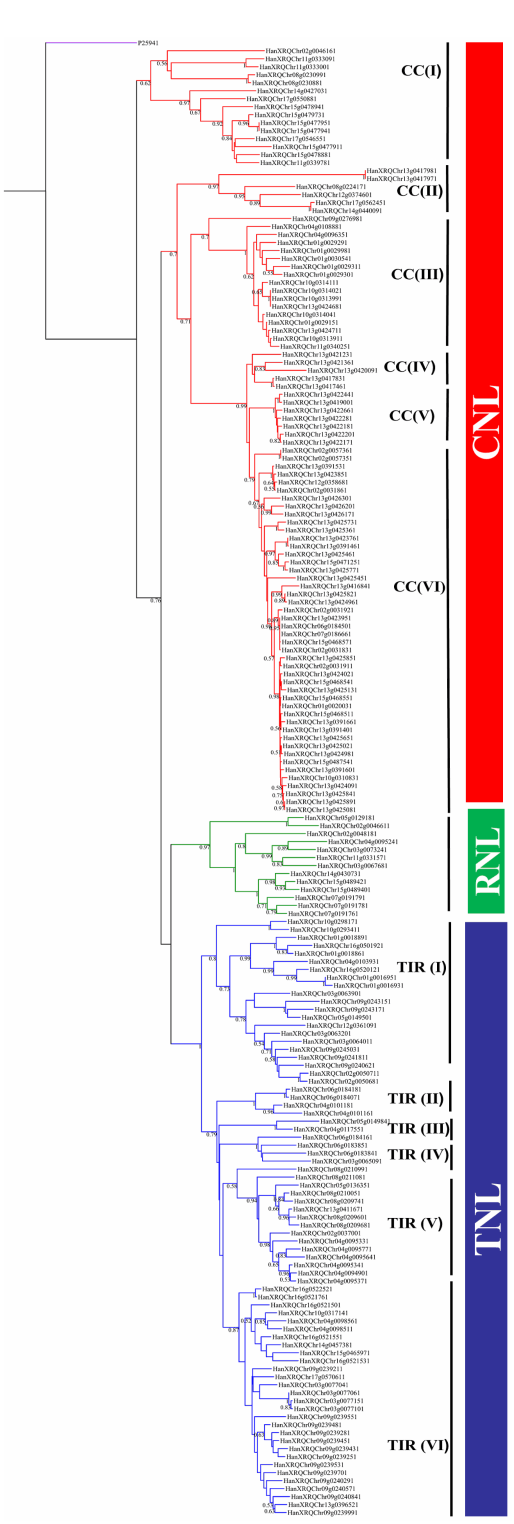
Figure 3. Maximum likelihood (ML) tree featuring NBS groups based on the conserved domains of the CNL, TNL, and RNL genes from Helianthus annuus . The ML tree was constructed using the JTT + G + I (Jones–Taylor–Thornton with γ distribution and invariant sites) model with 1000 bootstrap replicates. The ML tree was rooted using a Streptomyces coelicolor NBS containing protein, P25941, as an outgroup. The clades TNL (blue), CNL (red), and RNL (green) and outgroup (purple) are color-coded. Subclades are mentioned as TIR (I) to TIR (VI) and CC (I) to CC